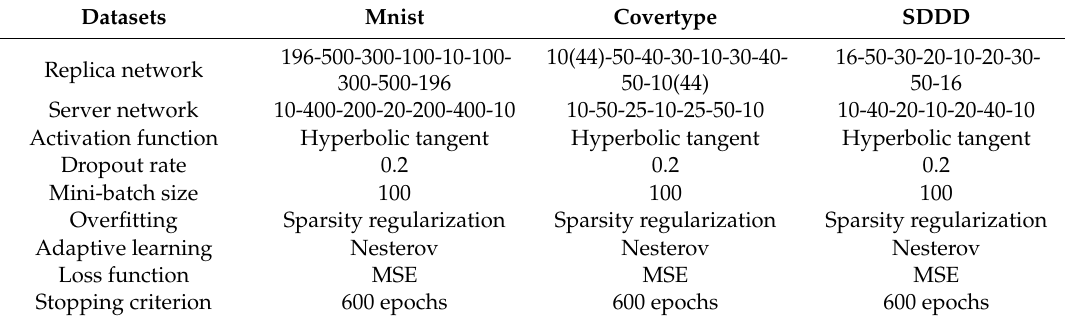
Table 2. Parameters for